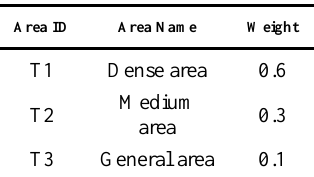
Table 3. Weights of hotpots